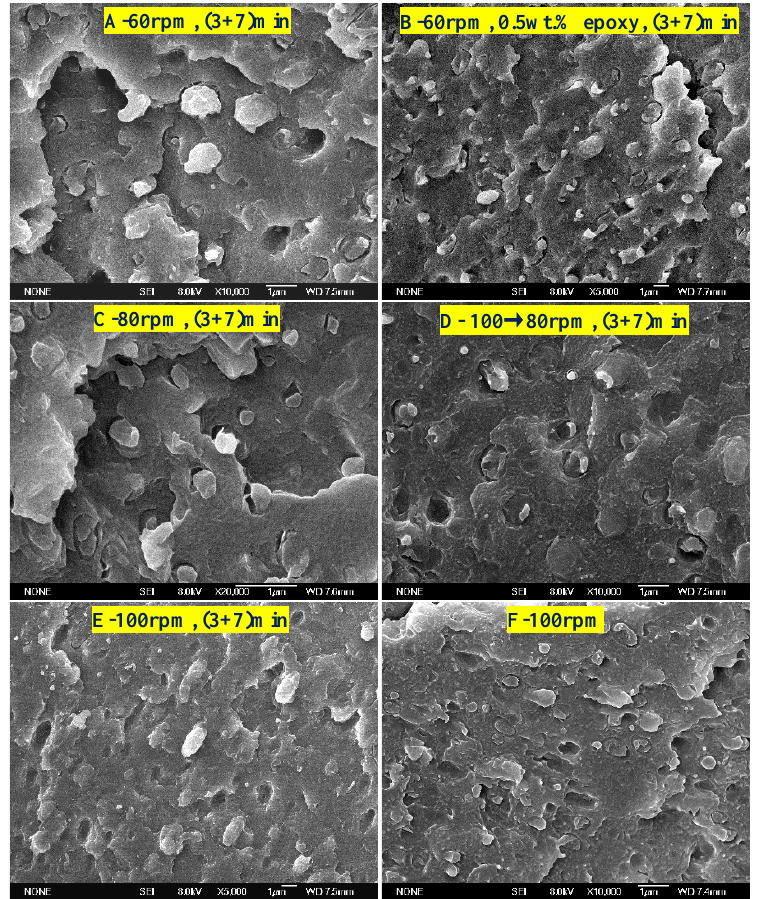
Figure 8. SEM images of the 70/30/1 wt. % PTT/PC/MMT melt processed at 240 °C with the indicated shear rates and by using the two-step mode of (3 + 7) min. The 100 → 80 rpm denotes that PTT was mixed with MMT at 100 rpm for 3 min firstly and then PC was added and mixing continued for 7 min. Sample D was with 0.5 wt. % epoxy resin addition. The MMT is Cloisite ® 25A.